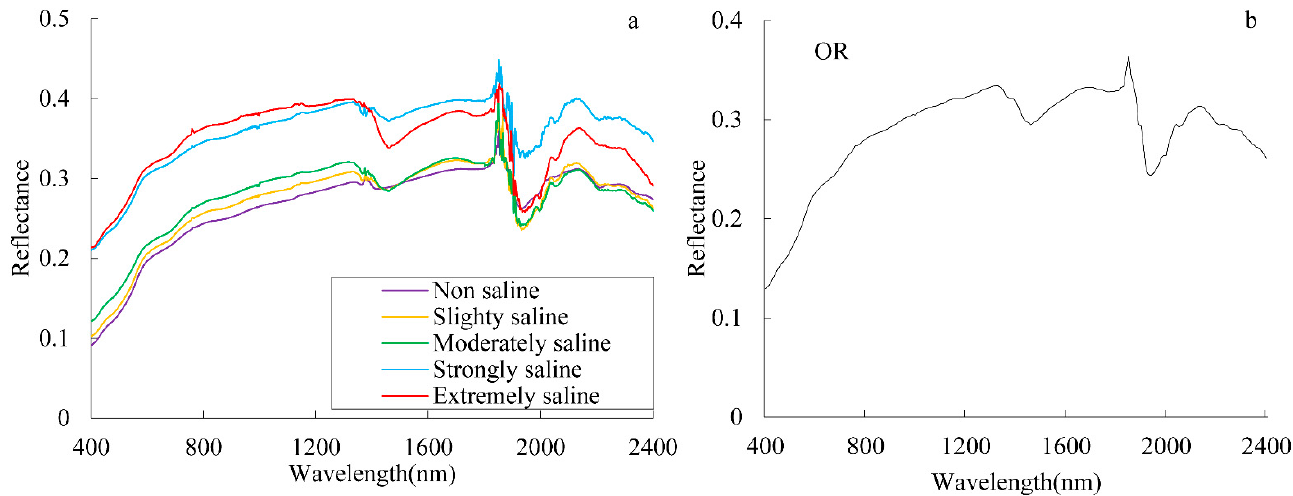
Figure 2. Hyperspectral reflectance of the soil measured on the ground under different saline levels ( a ) and mean original spectral reflectance ( n = 130) ( b ).